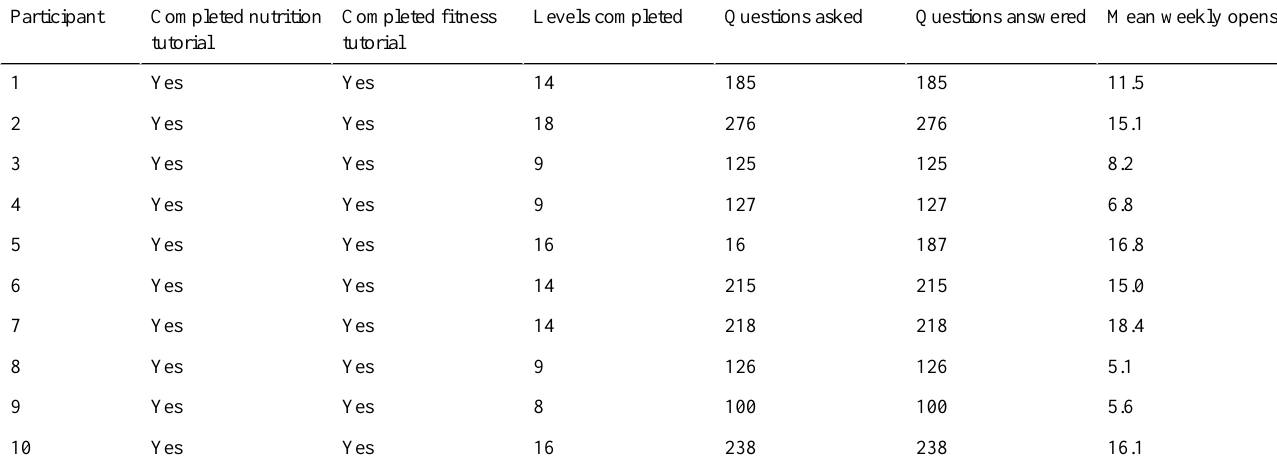
Table 1. Usage data for key